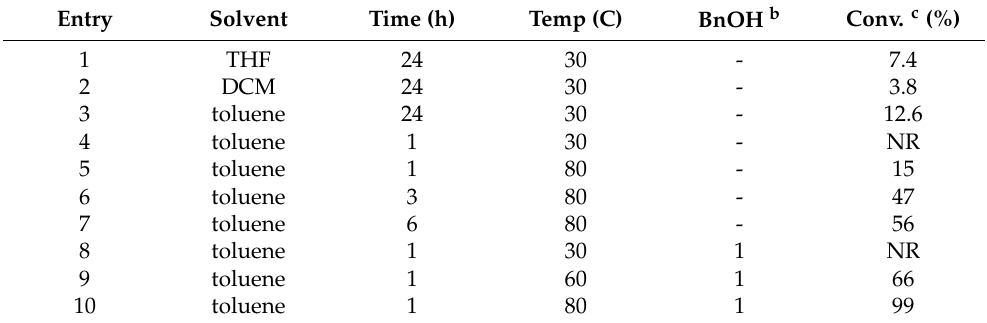
Table 1. Ring-opening polymerization of ε -CL using compound 4 as initiator a in different solvents.